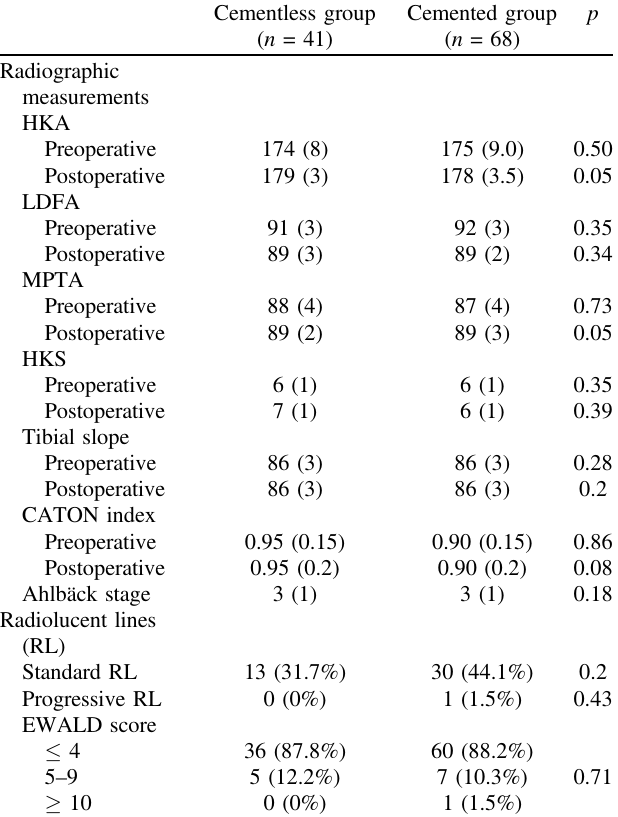
Table 2. Clinical pre- and postoperative assessments. Table 3. Radiographic pre- and postoperative